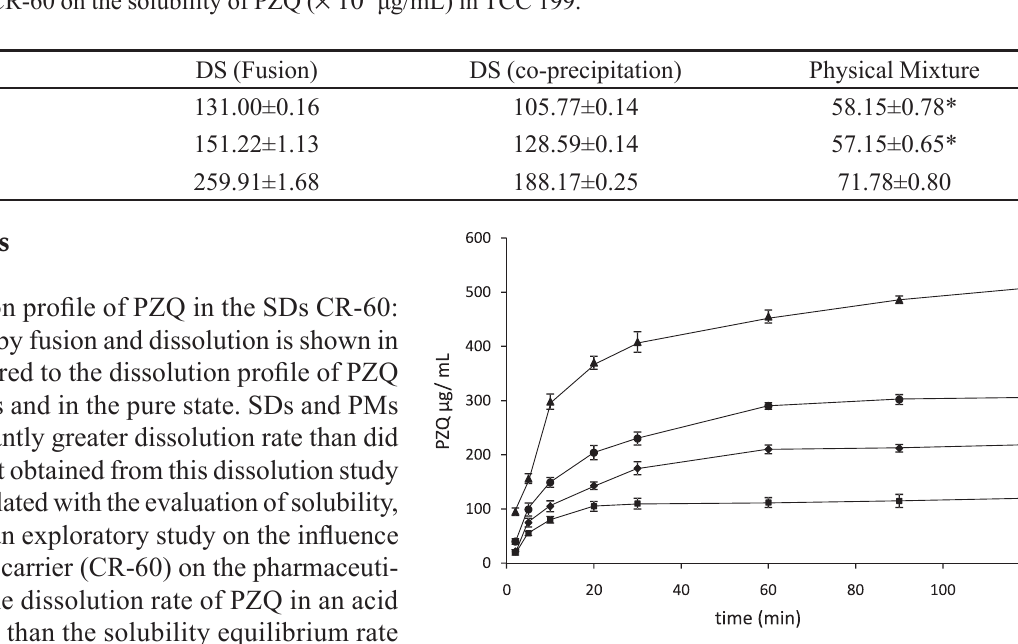
TABLE IV - Effect of CR-60 on the solubility of PZQ ( × 10 -1 μg/mL) in TCC 199.